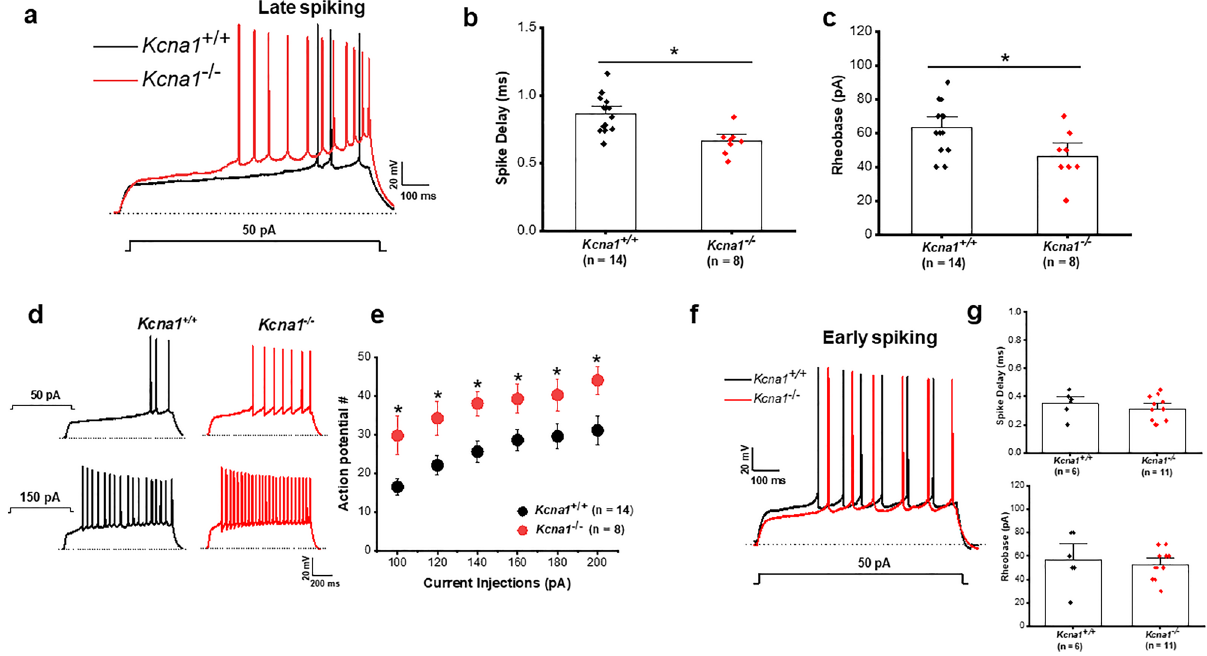
Figure 3. K v 1.1-containing channels regulate intrinsic firing properties of late-spiking (LS) but not early spiking (ES) central lateral amygdala neurons. ( a ) CeL superimposed representative traces show AP firing of LS neurons from Kcna1 + / + (black trace) and Kcna1 −/− (red trace) recorded in response to a 50-pA stimulus. ( b,c ) Pooled data showing significant decrease in the spike delay ( b ) and rheobase ( c ) in CeL LS neurons of Kcna1 −/− compared to Kcna1 + / + mice. Kcna1 + / + , n = 14 cells from 6 mice; Kcna1 −/− , n = 8 cells from 7 mice. ( d ) Representative traces of repetitive firing elicited by depolarizing current injection of 50 (upper traces) and 150 pA (lower traces) in LS neurons from Kcna1 + / + (black traces) and Kcna1 −/− (red traces) mice. The traces illustrate the increase in the firing frequency of action potentials in both Kcna1 + / + and Kcna1 −/− mice in response to stimulus of higher magnitude. ( e ) The number of action potentials elicited by 1.2 s current injections was plotted against current injection to show the firing response of LS neurons as a function of the stimulus intensity. LS neurons from Kcna1 −/− mice showed increased AP firing compared to Kcna1 + / + mice suggesting that LS neurons of CeL from Kcna1 −/− possess increased intrinsic excitability. ( f ) Superimposed representative traces showing AP firing of ES neurons Kcna1 + / + (black trace) and Kcna1 −/− (red trace) mice recorded in response to a 50-pA stimulus. ( g ) In contrast to LS neurons, ES neurons showed no difference either in the spike delay (top) or rheobase (bottom) in Kcna1 −/− compared to Kcna1 + / + mice. Kcna1 + / + , n = 6 cells from and 6 mice; Kcna1 −/− , n = 11 cells from 7 mice. Dotted lines indicate the resting membrane potential. *p <